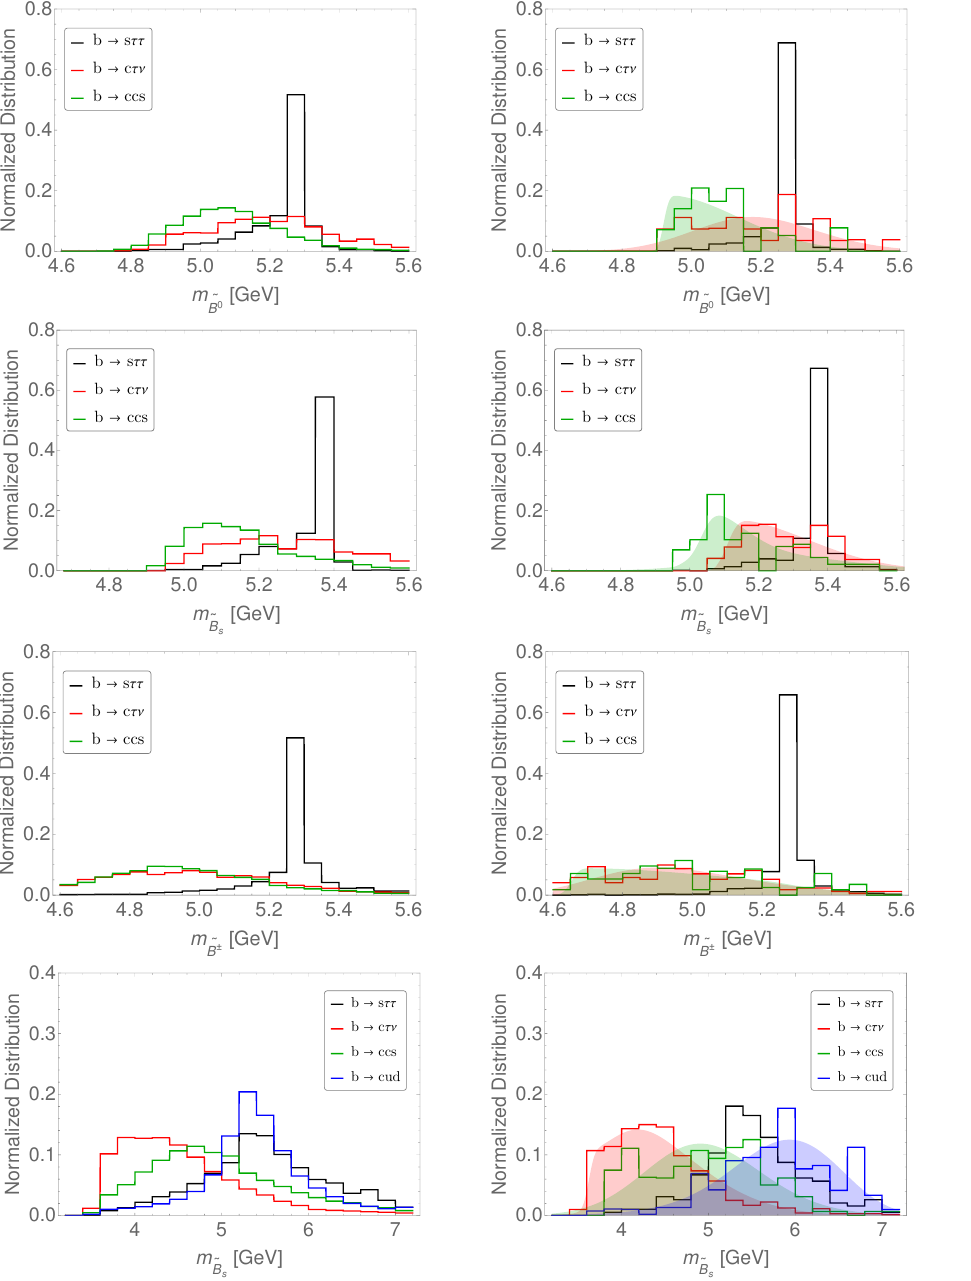
Figure 6 . Normalized distributions of the reconstructed B -meson mass for the measurements of B 0 → K ∗ 0 τ + τ − (1st row) and B + τ − (2nd row) and B + → K + τ + τ − (3rd row) and s → φτ B s → τ + τ − (4th row), before (left) and after (right) cuts 1-3 are applied. In the right column, the shaded regions represent the background fittings using skew normal